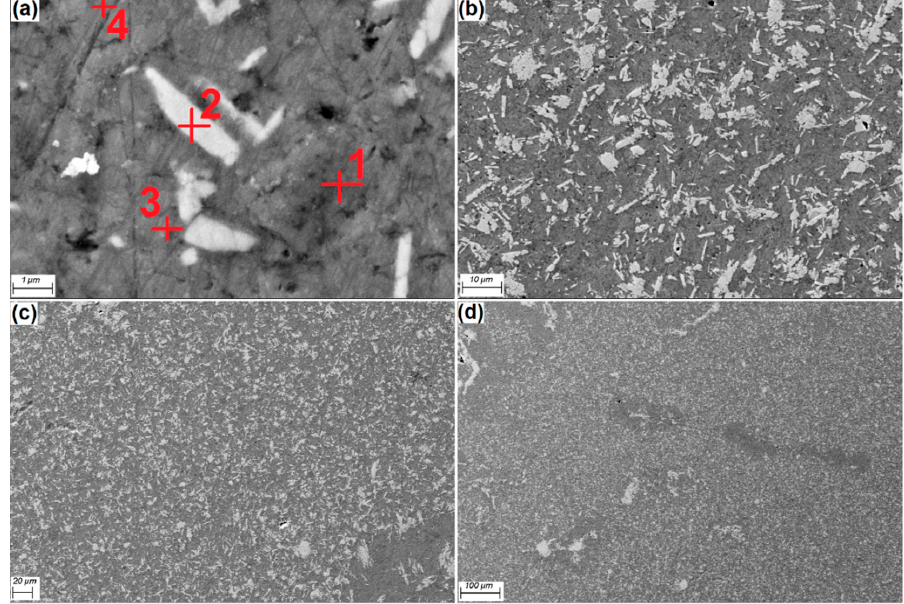
Figure 2. FE-SEM micrographs of Al-15Fe 3 O 4 composite in different magnifications ( a ) 1 μ m scale, ( b ) 10 μ m scale, ( c ) 20 μ m scale and ( d ) 100 μ m scale.